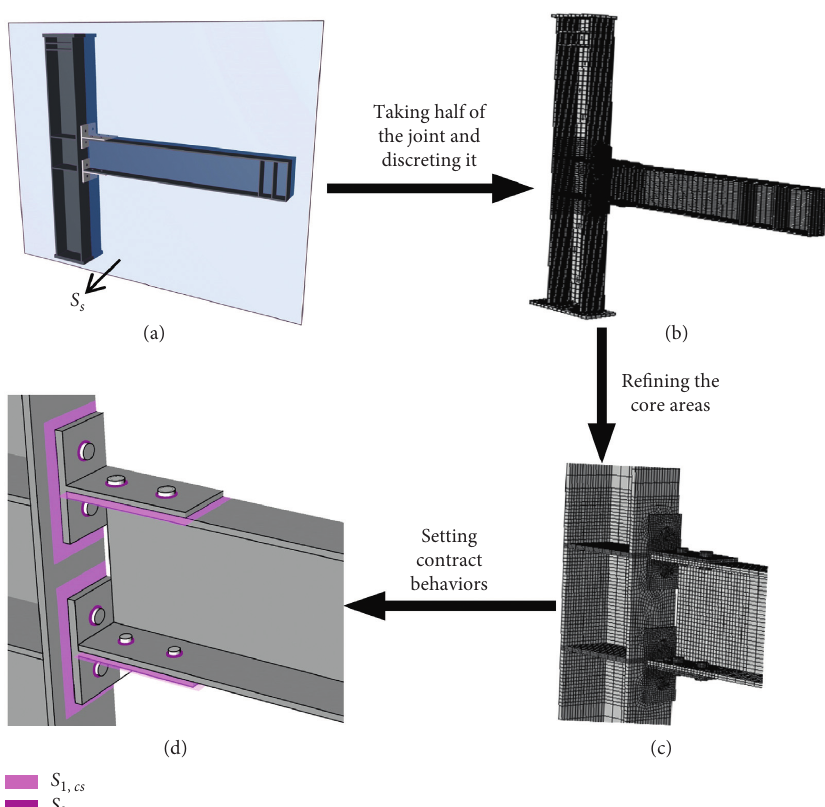
Figure 9: The finite element modeling of T-stub connection. Note: S s is the symmetry plane of the connection; S 1, cs the contact surfaces between the T-stub and the beam/column; S 2, cs the contact surfaces between the nut and the T-stub/beam/column.